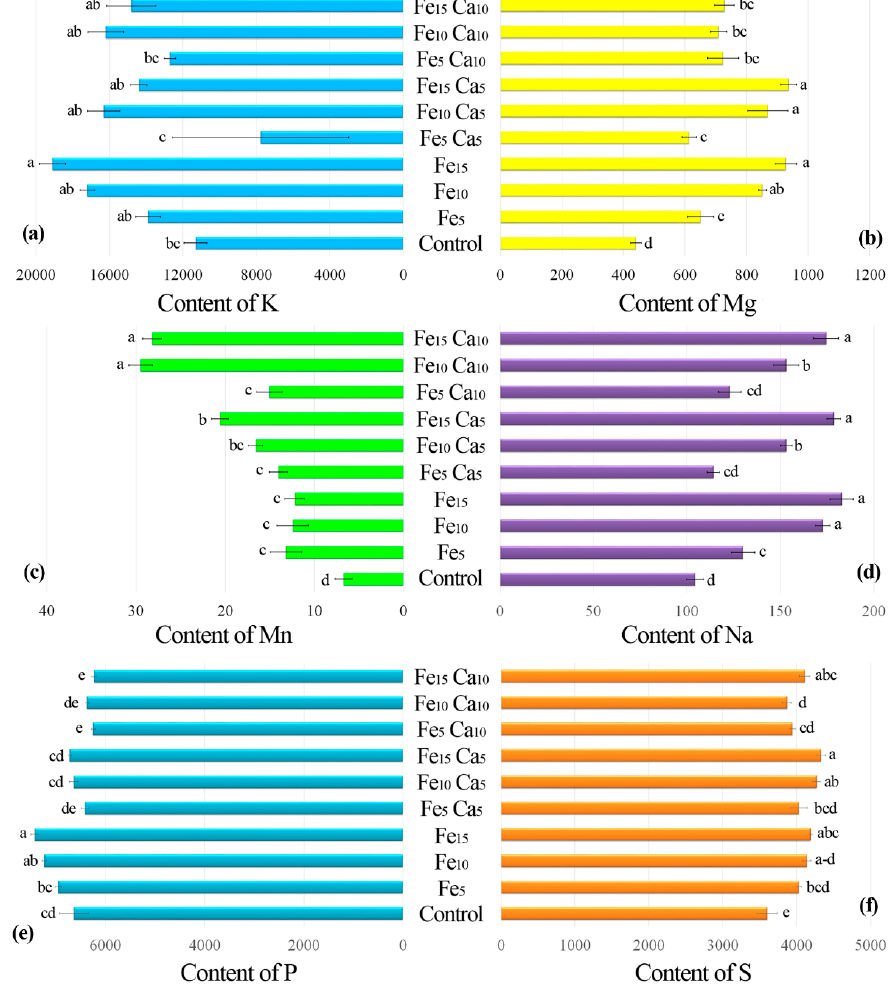
Figure 5. Content of K ( a ), Mg ( b ), Mn ( c ), Na ( d ), P ( e ), and S ( f ) (mg kg − 1 DW) in mushrooms exposed to particular experimental systems. n = 5, identical lower cases (a, b…) denote non- significant differences between mean content of particular metals in Pholiota nameko fruit bodies growing in particular experimental systems according to post-hoc Tukey’s HSD test.